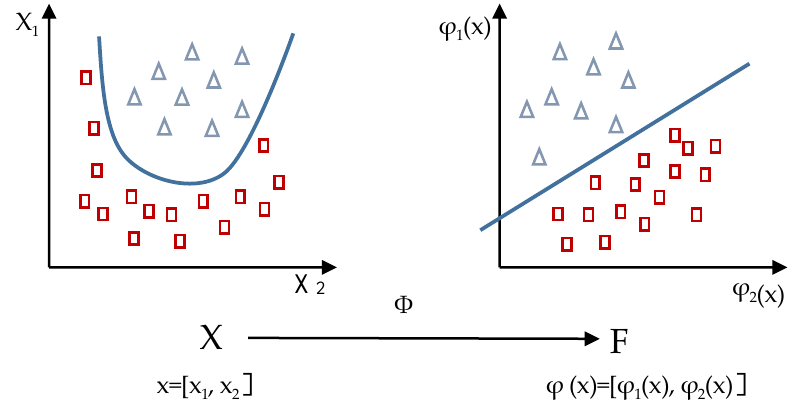
ff ect on the separation hyperplane of two-class Figure 3. Mapping kernel functions: Effect on the separation hyperplane of two-class datasets. Figure 3. Mapping kernel functions: E